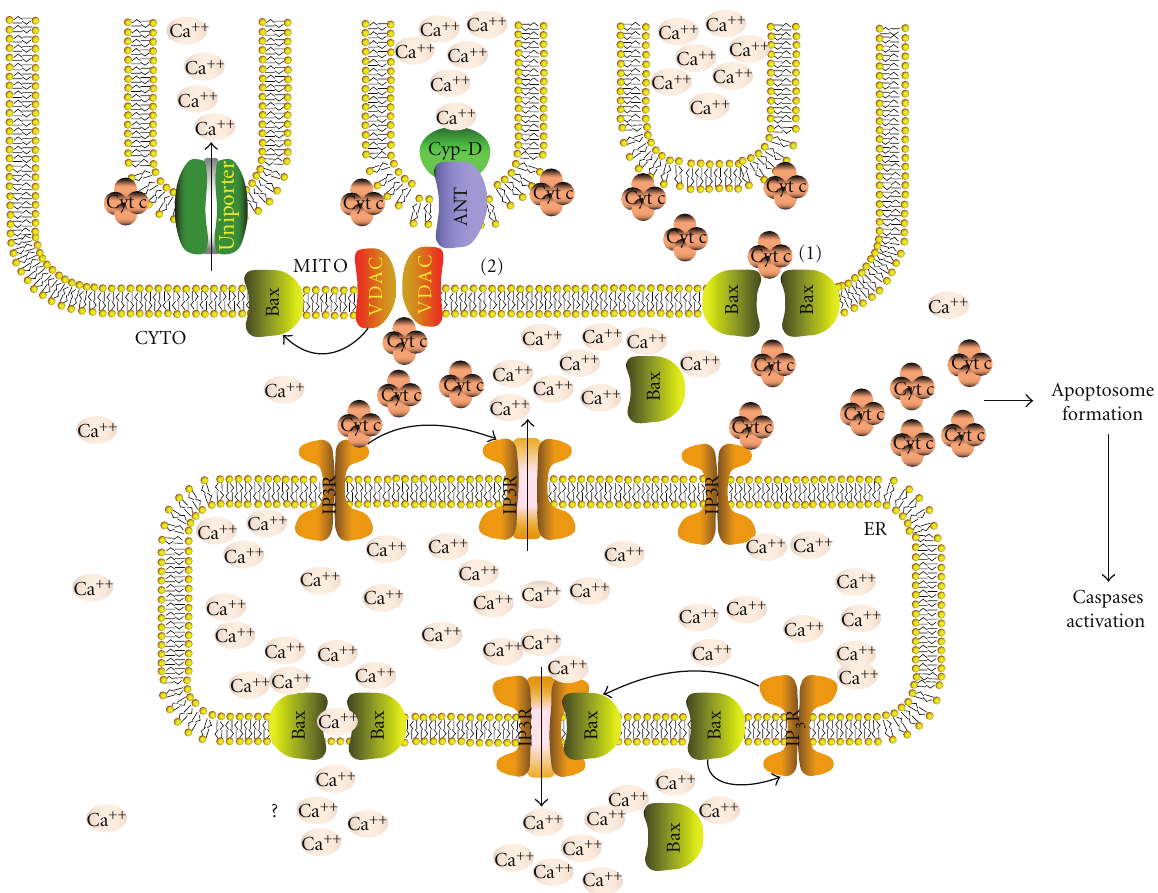
Figure 1: Ca 2+ signals between ER and mitochondria coordinate the precommitment phase of apoptosis: amplification loops between Bax activation and Ca 2+ release from ER amplify cytochrome c release to a level su ffi cient for apoptosome nucleation and caspase activation. Cytochrome c released by Bax (1) or VDAC (2) mitochondrial pores magnifies Ca 2+ e ffl ux from IP 3 channels; the consequent local high cytosolic Ca 2+ recruits Bax ( via calpain?) to mitochondria or ER membrane, stimulating more cytochrome c release and more Ca 2+ e ffl ux,